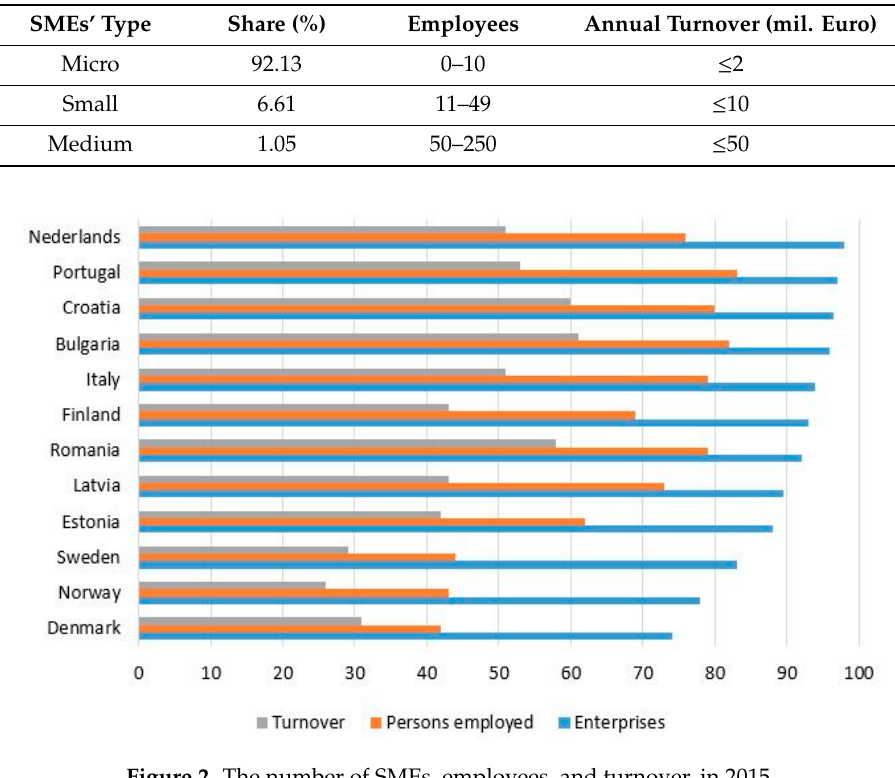
Figure 2. The number of SMEs, employees, and turnover, in 2015. trade / repair of vehicles and